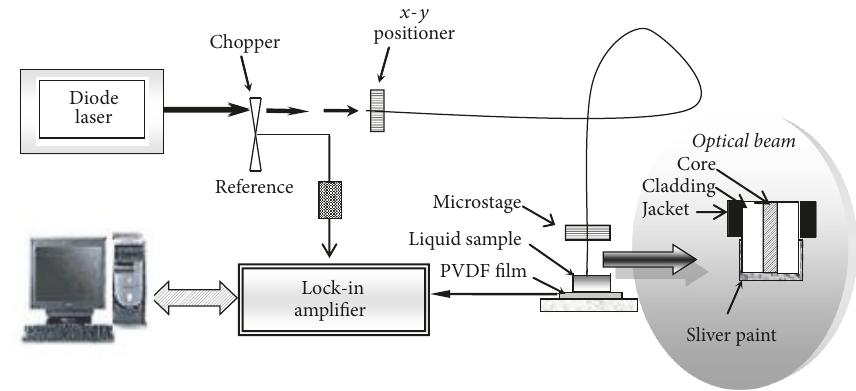
Figure 1: Schematic diagram of OF-TWC